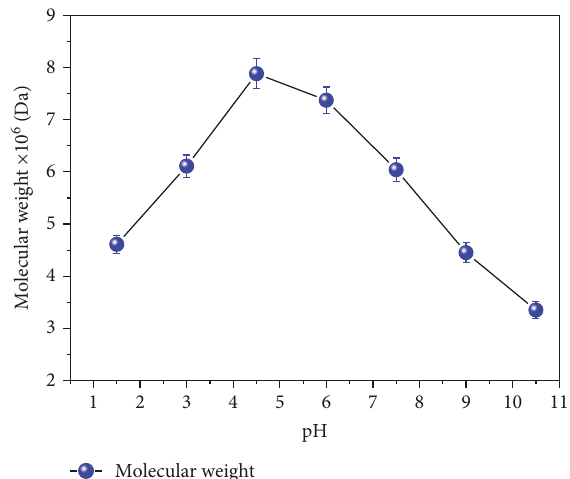
Figure 6: E ff ect of pH on the molecular weight of PAD.